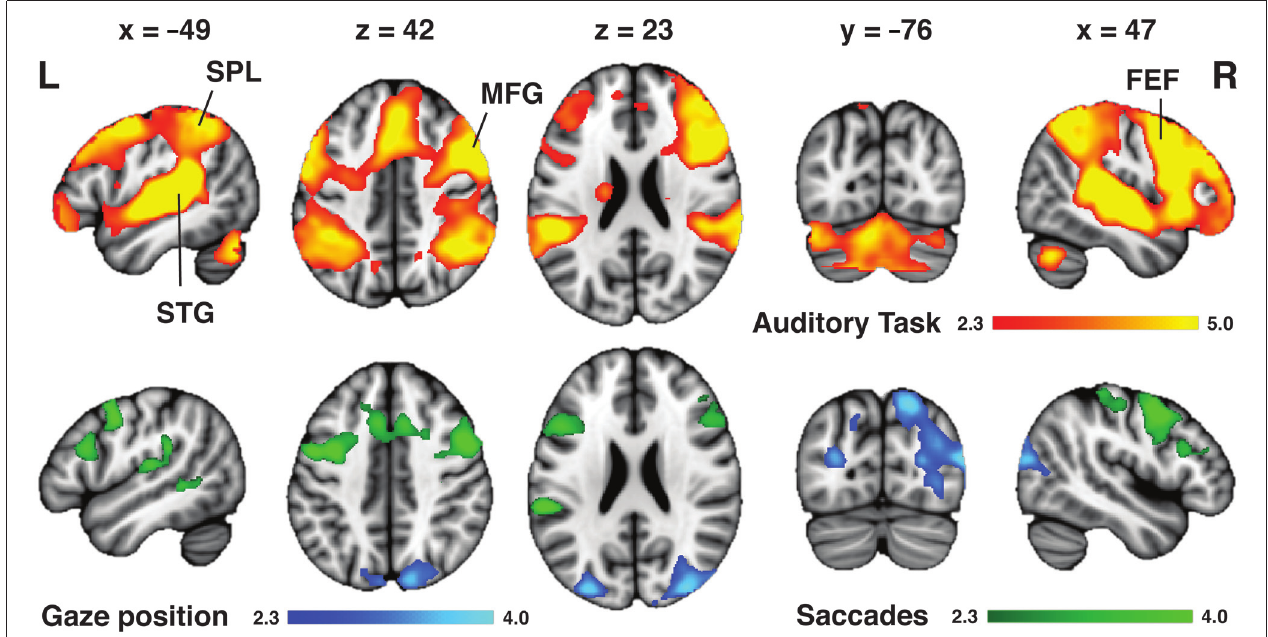
FIGURE 4 | Neuroimaging correlates of auditory attention task and variability in eye movement. Orange: across all trials, attentive listening was associated with activation of a widespread auditory network (superior temporal gyri (STG) and sulci (STS) bilaterally) as well as the dorsal attention network [DAN; superior parietal lobes (SPL), frontal eye fields (FEF)] and middle frontal gyri (MFG) bilaterally. However, only the SPL and FEF were associated with individual differences in eye movement control. Blue: subjects that displayed the largest left-right gaze position bias following spatial auditory cues had greater activation of the SPL during the attentive listening periods. Green: subjects that displayed the largest reduction in saccade rate during listening trials compared to rest had greater activation of the FEF and left posterior temporal lobe during the cue period that preceded each trial. Colorbars show cluster-corrected z -scores.